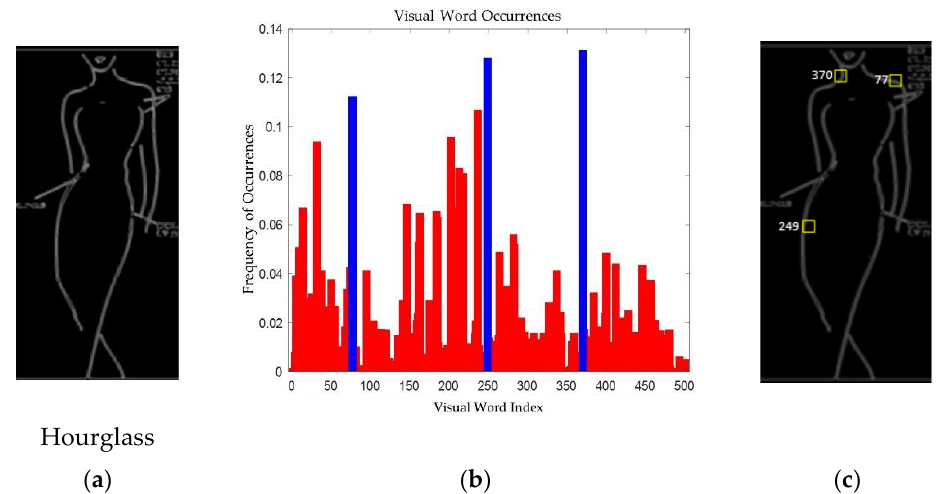
Figure 10. ( a ) Input image of body shape hourglass, ( b ) histogram of visual words occurrence for the input image with a vocabulary of 500 visual words with 3 most frequently occurring visual words, and ( c ) the location of the 3 visual words occurring in the input image (index and location marked in the input image). Note that the maximum occurrence of visual words corresponding to a body shape classifies the image to that category.